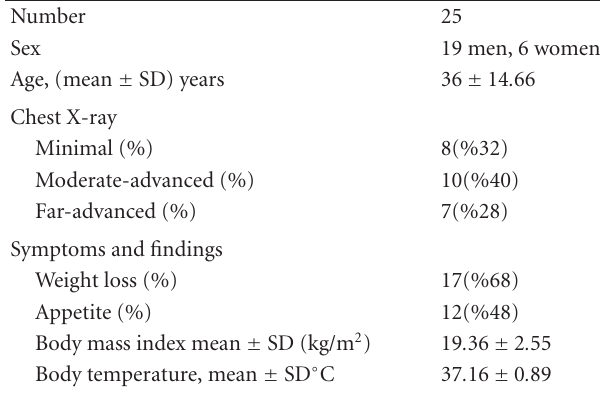
Table 1: Demographic characteristics of patients with